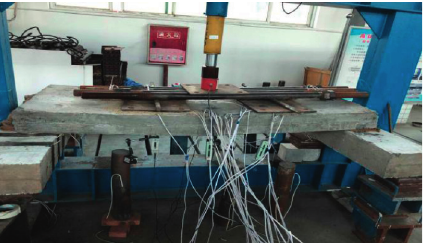
Figure 28: Failure mode of LPCSHTHSC under ultimate load.